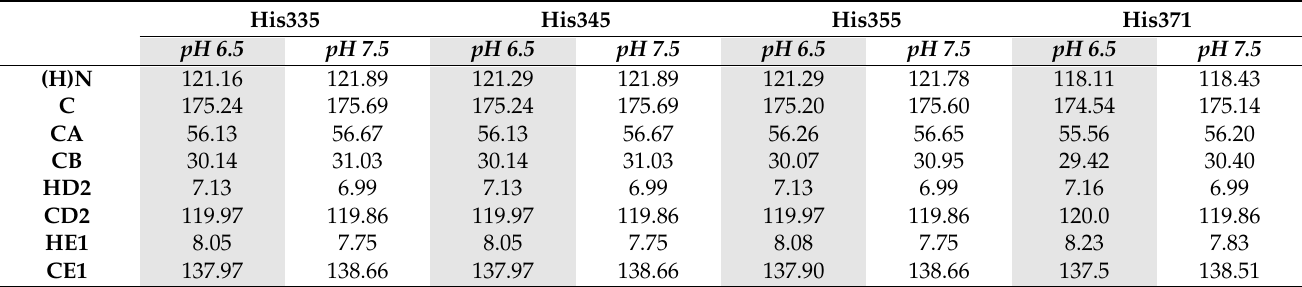
Table 1. Chemical shift (ppm) signal assignment of the histidine residues in hNDRG1*C at pH 6.5 and pH